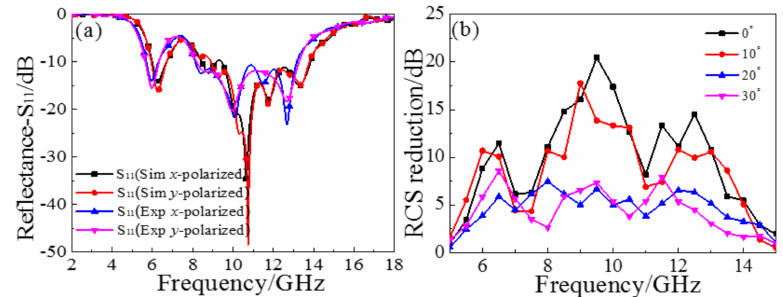
Figure 9. ( a ) The simulated and measured reflectance results of the sample; ( b ) RCS reduction of the sample under oblique incident waves from 0 ◦ to 30 ◦